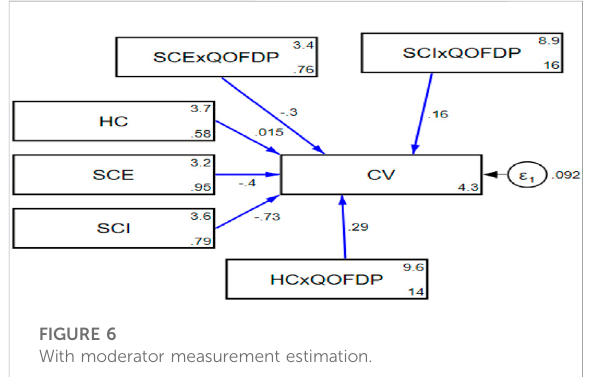
FIGURE 6 With moderator measurement